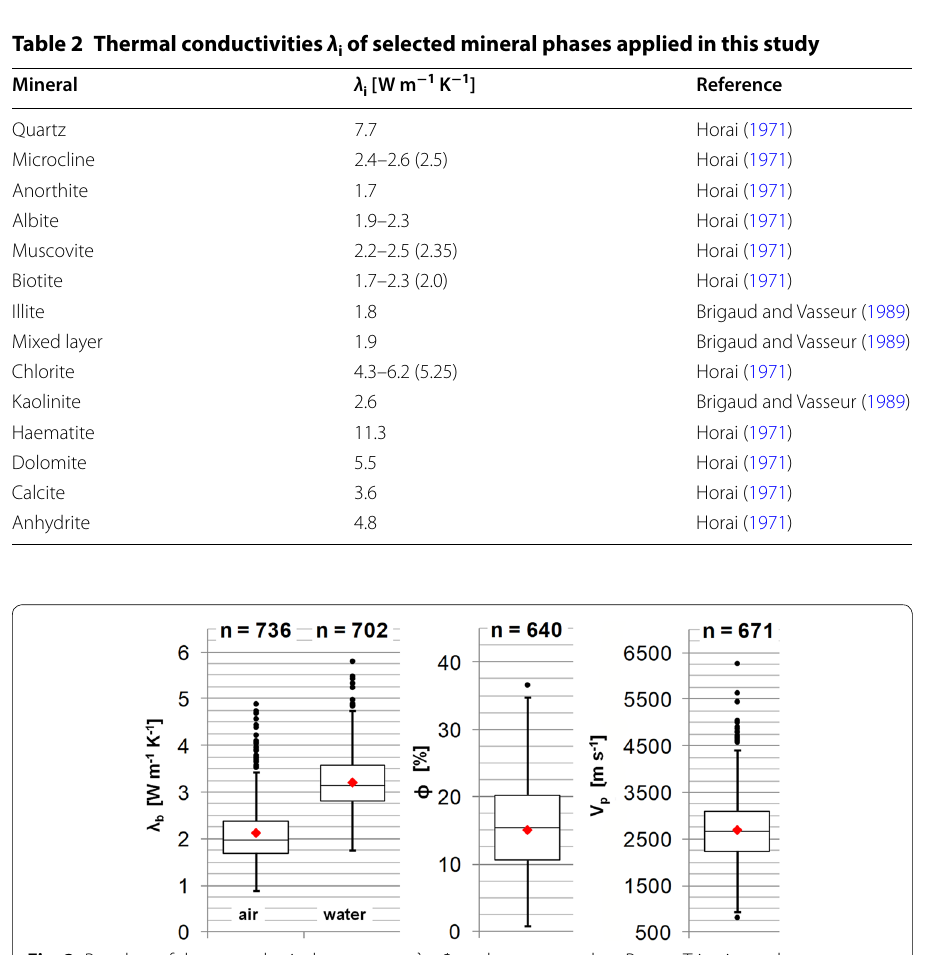
Fig. 2 Boxplots of the petrophysical parameters λ b , Φ , and v p measured on Permo-Triassic sandstones; horizontal lines place medians of boxplots and red dots give mean values ( n number of samples, = air air-saturated sandstones, water water-saturated sandstones) = = Table 3 Statistical parameters of petrophysical and mineralogical data (RVA) measured on Permo-Triassic sandstones